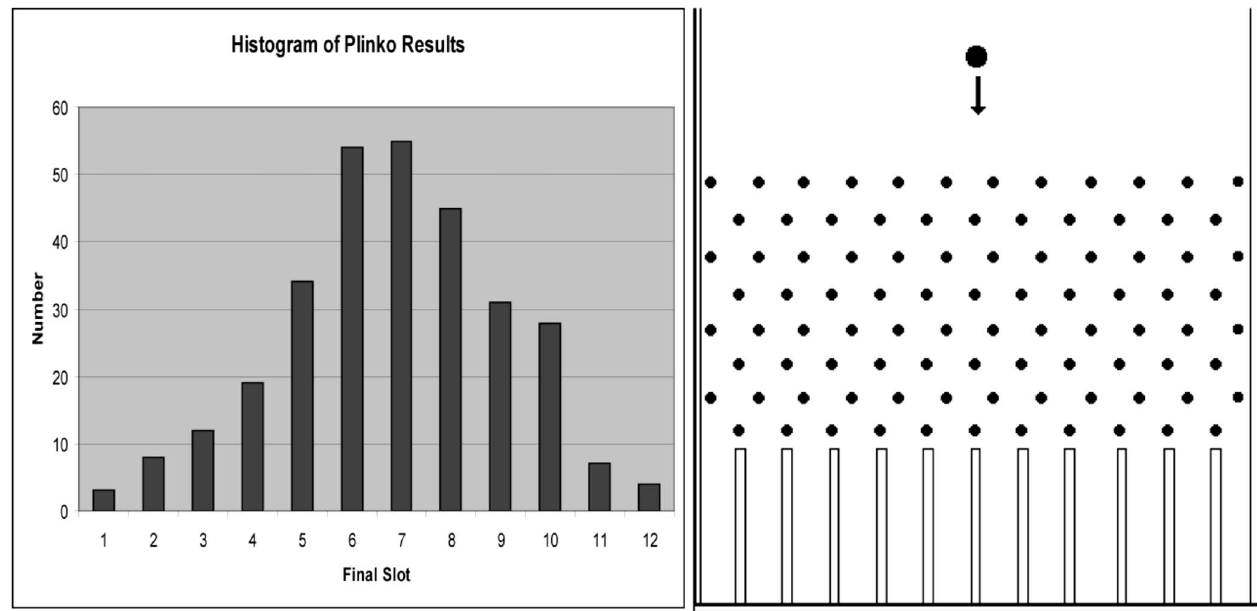
FIG. 3. A depiction of a Plinko game and a histogram of results from a series of 300 releases of the marble from the same starting